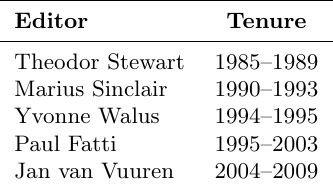
Table 1: Editors of